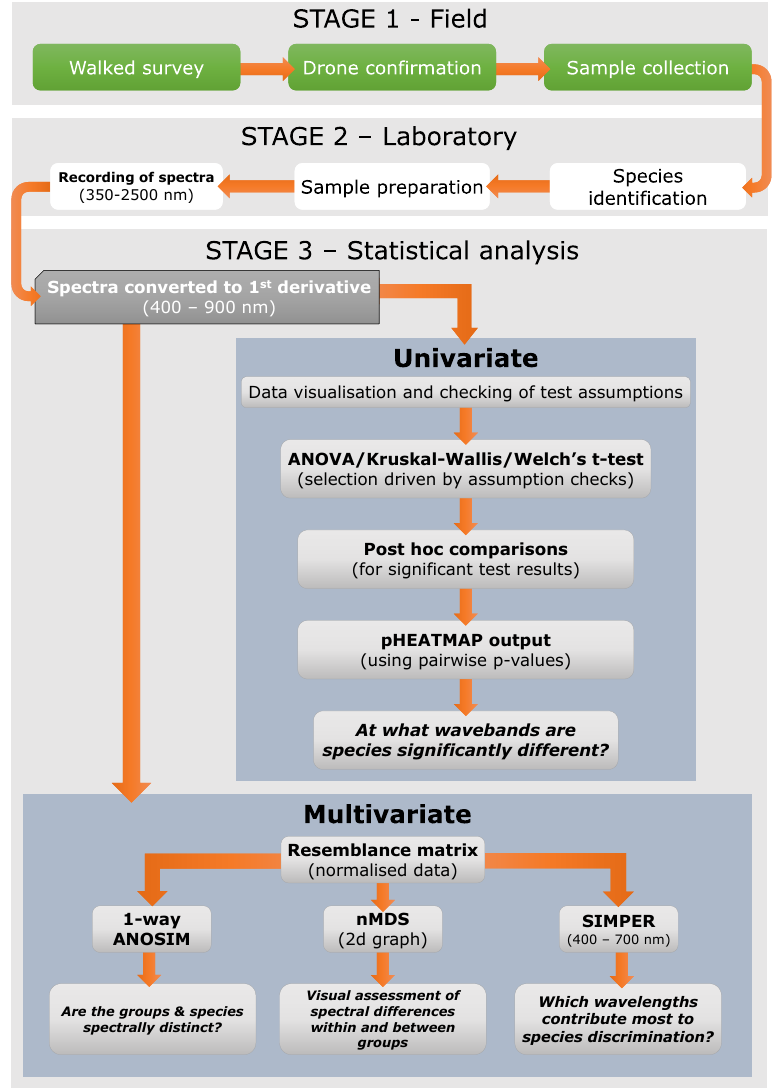
Figure 2. Overall research flow chart summarizing the methodological processes of the field work, laboratory, and statistical analysis